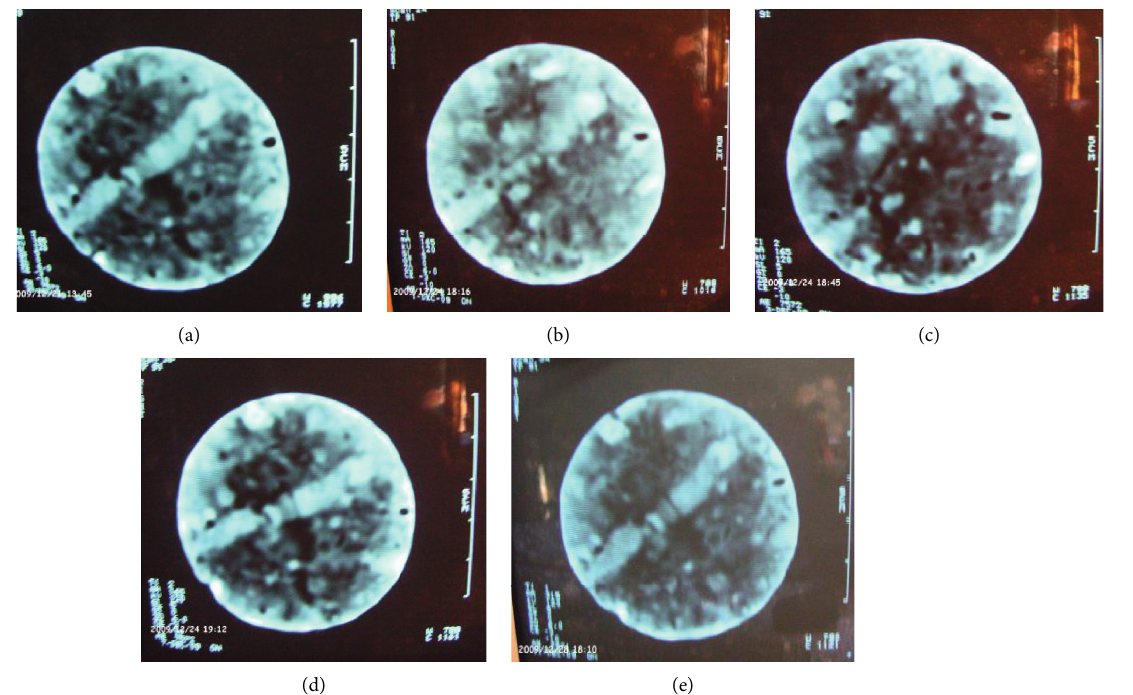
Figure 15: CT images of the b section position of the LC-1 sample with cycle amplitude Δ w � 10%. (a) Zero cycles. (b) One cycle. (c) Two cycles. (d) Four cycles. (e) Six